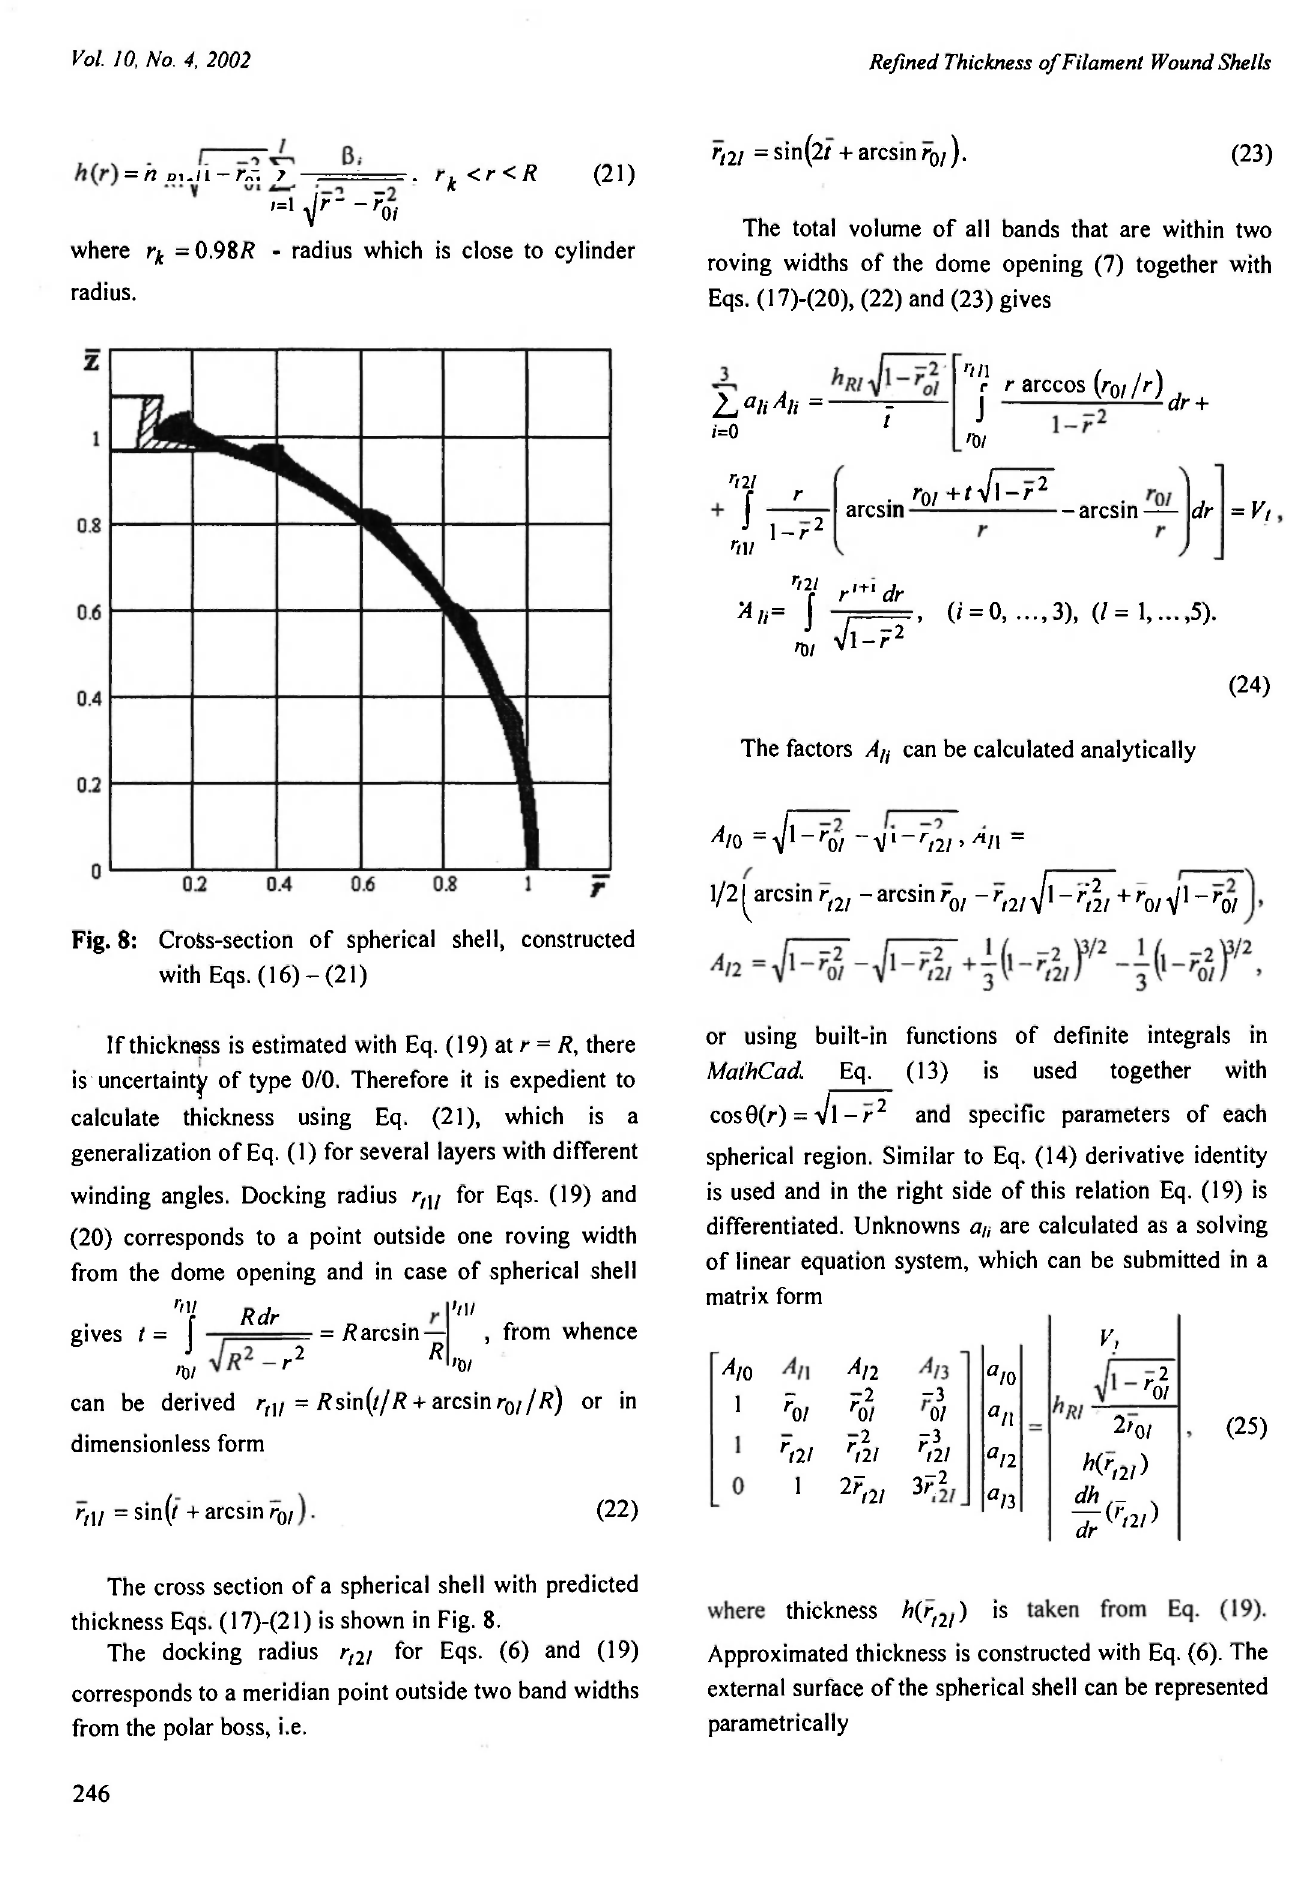
Fig. 8: CroSs-section of spherical shell, constructed with Eqs. (16)-(21) If thickness is estimated with Eq. (19) at r = R, there is uncertainty of type 0/0. Therefore it is expedient to generalization of Eq. (1) for several layers with different winding angles. Docking radius r, u for Eqs. (19) and (20) corresponds to a point outside one roving width from the dome opening and in case of spherical shell